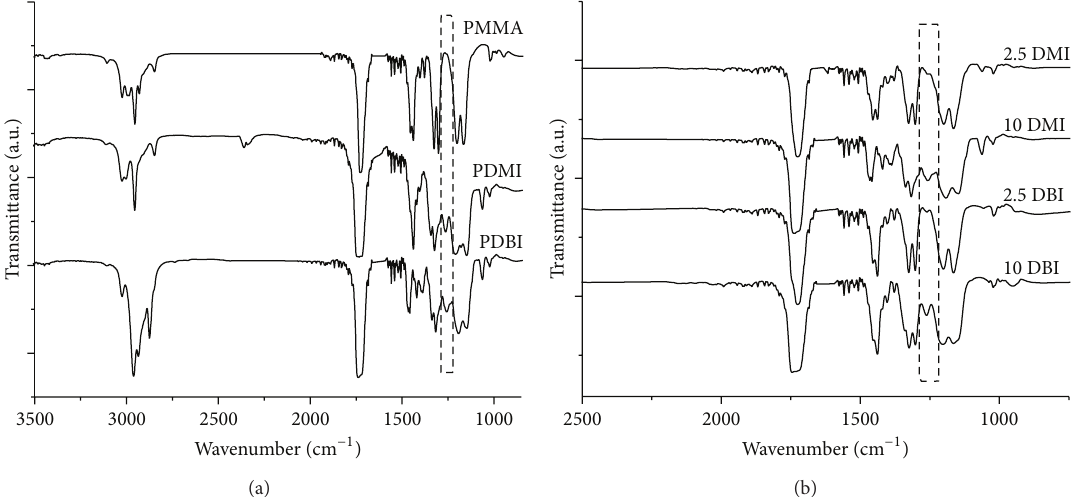
Figure 4: FTIR spectra of (a) PMMA, PDMI, and PDBI and (b) PMMA denture base materials modified with 2.5 wt% and 10 wt% of DMI and